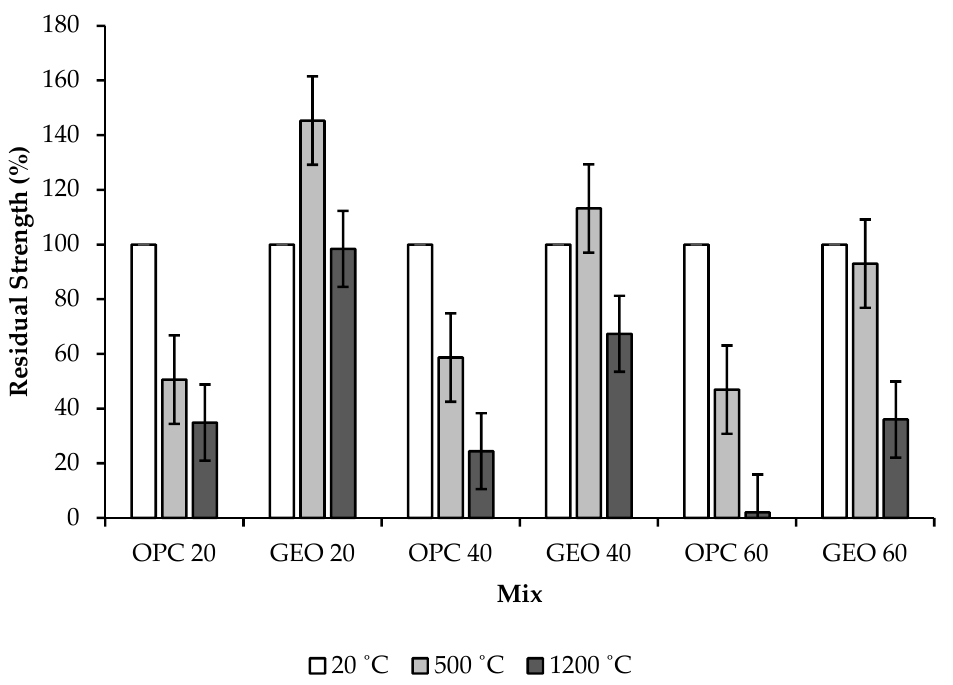
Figure 5. Residual compressive strength of concrete specimens.